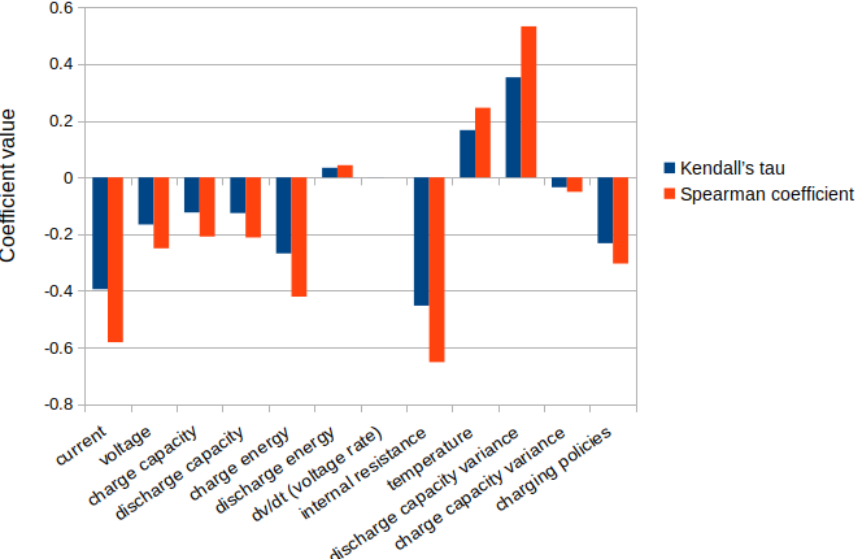
Figure 6. Results from variable importance analysis. Kendall’s tau and Spearman coefficient for all input features were evaluated. Values close to 0 mean no importance, while values close to either 1 or − 1 mean strong correlation.